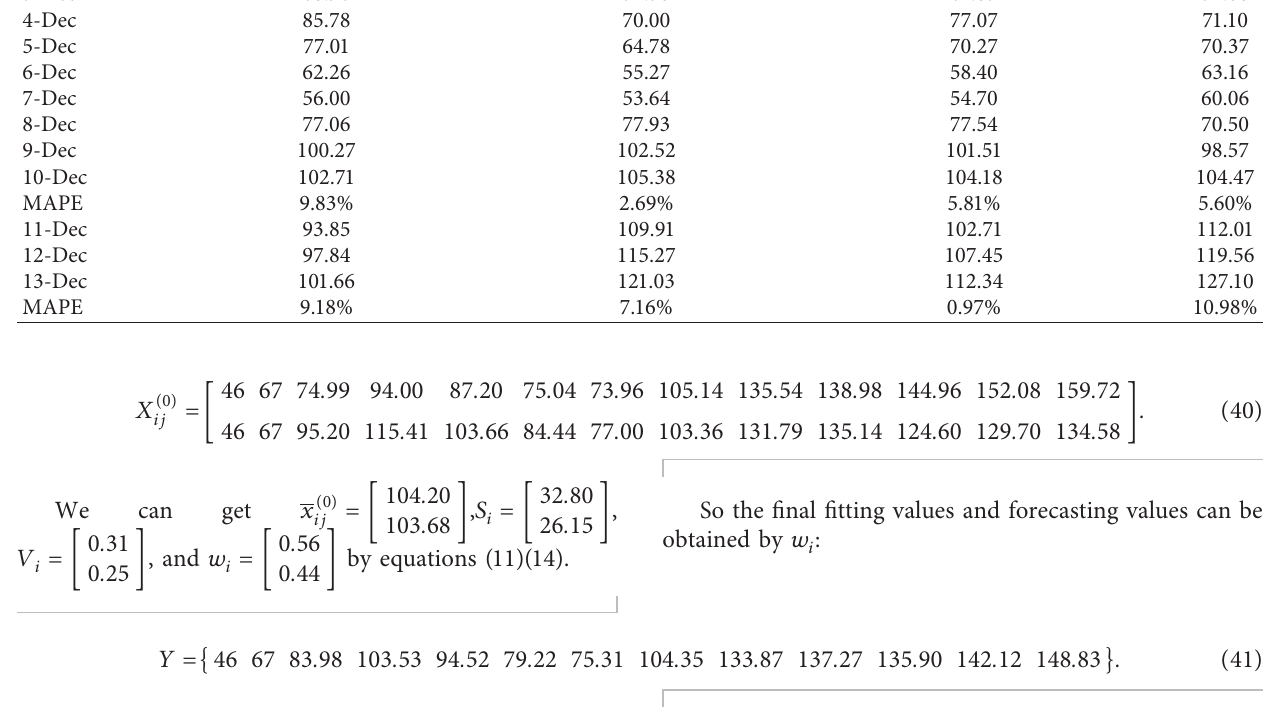
Table 3: The forecasting results of PM